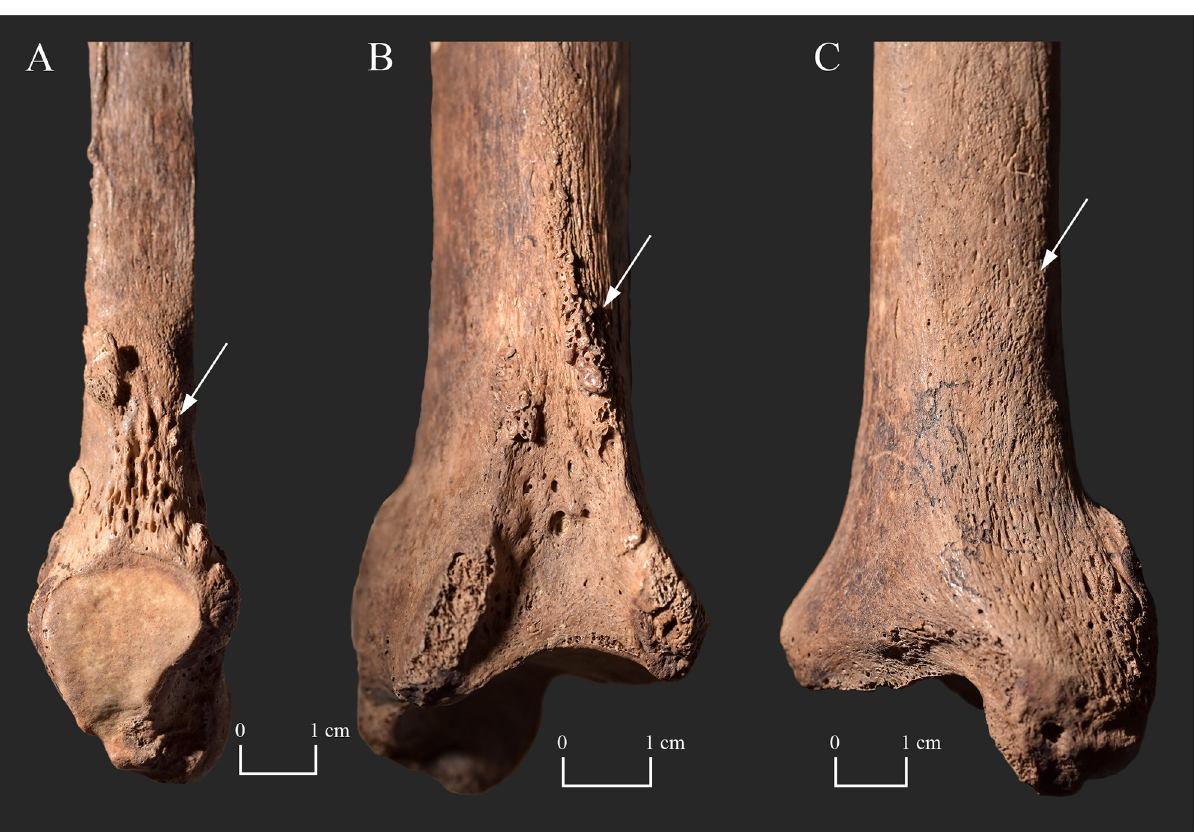
Fig 8. Exostoses on the distal part of the right A) fibula (medial surface–white arrow) and B) tibia (lateral surface–white arrow) of KD271; and C) Slight surface pitting and subperiosteal new bone formations on the distal part of the right tibia (medial surface–white arrow) of KD271.